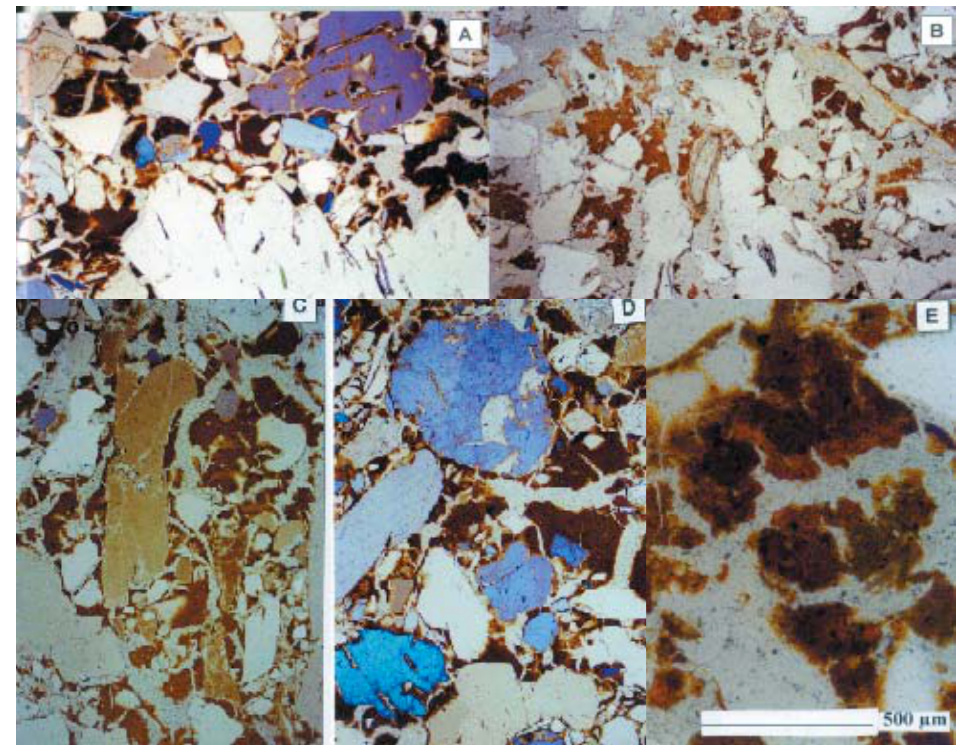
Figura 3. Fotomicrografias do horizonte Bh (foto A), transição Bh/Bs1 (foto B), Bs1 (fotos C e D) e horizonte plácico em Bs (foto